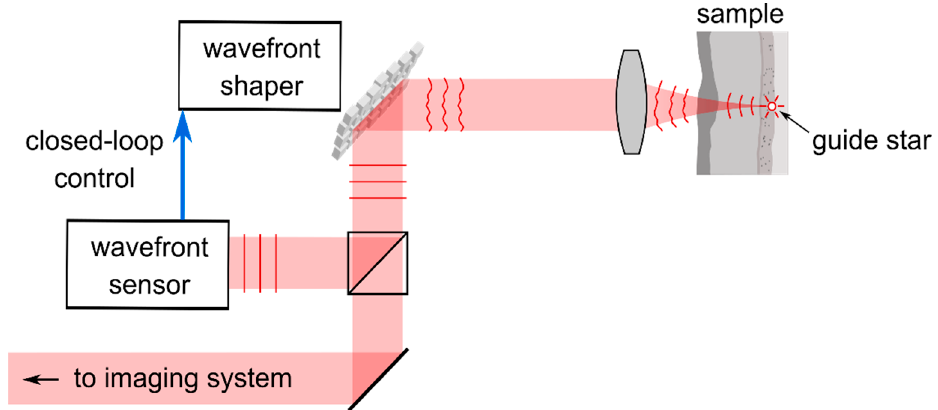
Figure 2. Principle of closed-loop sensor-based adaptive optics. Light emitted from a point-like guide star is detected at a sensor which quantifies aberrations of the wavefront. A closed-loop control is implemented to dynamically correct deviations from the ideal (flat) wavefront with a wavefront shaping element such as a deformable mirror. The approach enables diffraction-limited imaging in the vicinity of the guide star. Image adapted from [19].